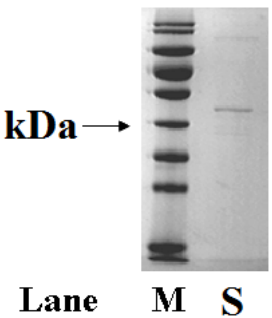
Figure A1. Sodium dodecyl sulfate-polyacrylamide gel electrophoresis (SDS-PAGE) images of the extracted actin. (Lane M): Protein marker, (Lane S): actin.